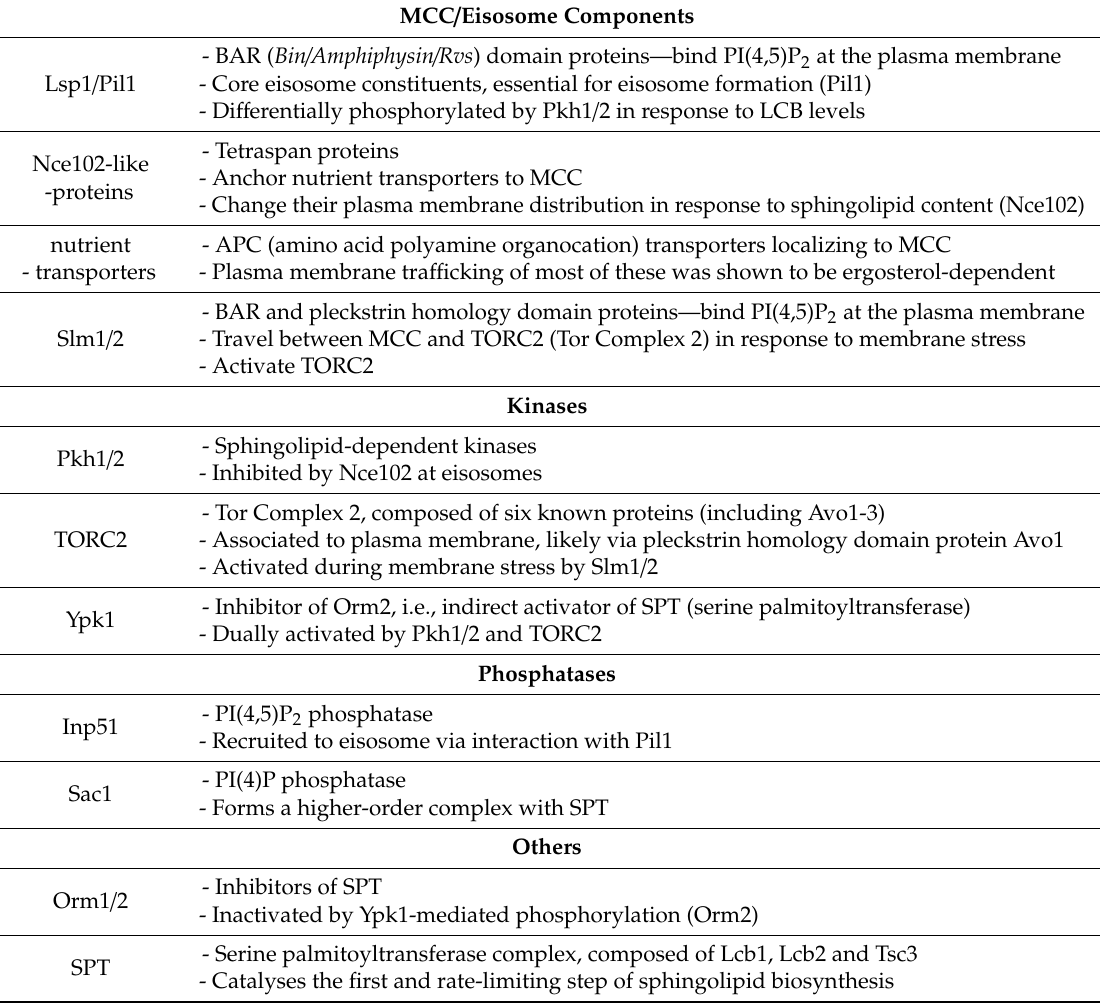
Table 1. Proteins involved in the MCC / eisosome-mediated regulation of sphingolipid metabolism (see also Figure